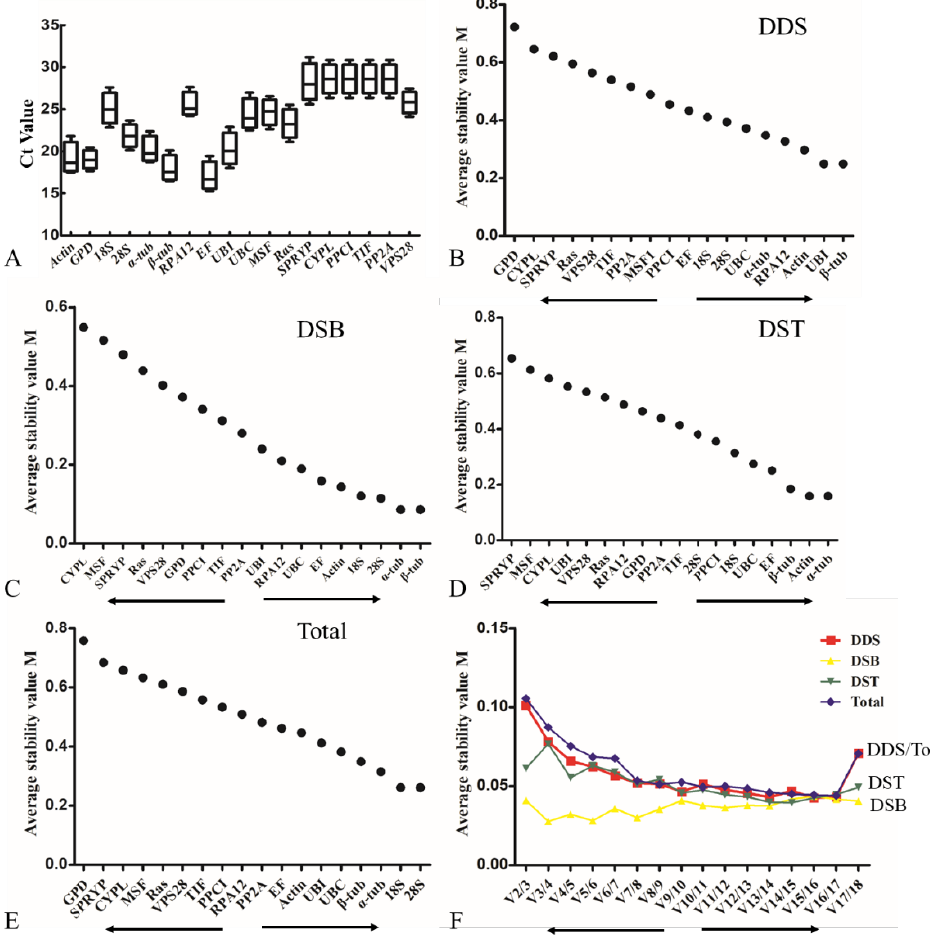
Figure 2. Expression stability analysis of eighteen candidate reference genes in Lentinula edodes . ( A ) variation in qRT-PCR values of eighteen candidate reference genes (CRGs) in all samples; ( B – E ) expression stability ranking of eighteen CRGs using geNorm under di ff erent development stages (DDS), di ff erent substrates (DSB), di ff erent stresses (DST) and all samples, respectively. ( F ) pairwise variation (Vn / Vn + 1) showing the optional number reference genes required in an accurate normalization.